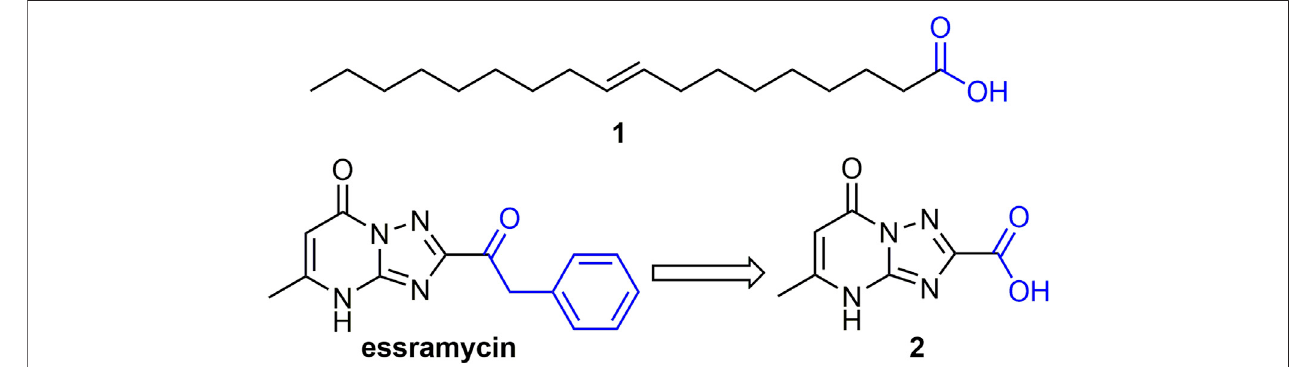
FIGURE 2 | Structures of representative fatty acids or carboxylic acids in antiviral activities.